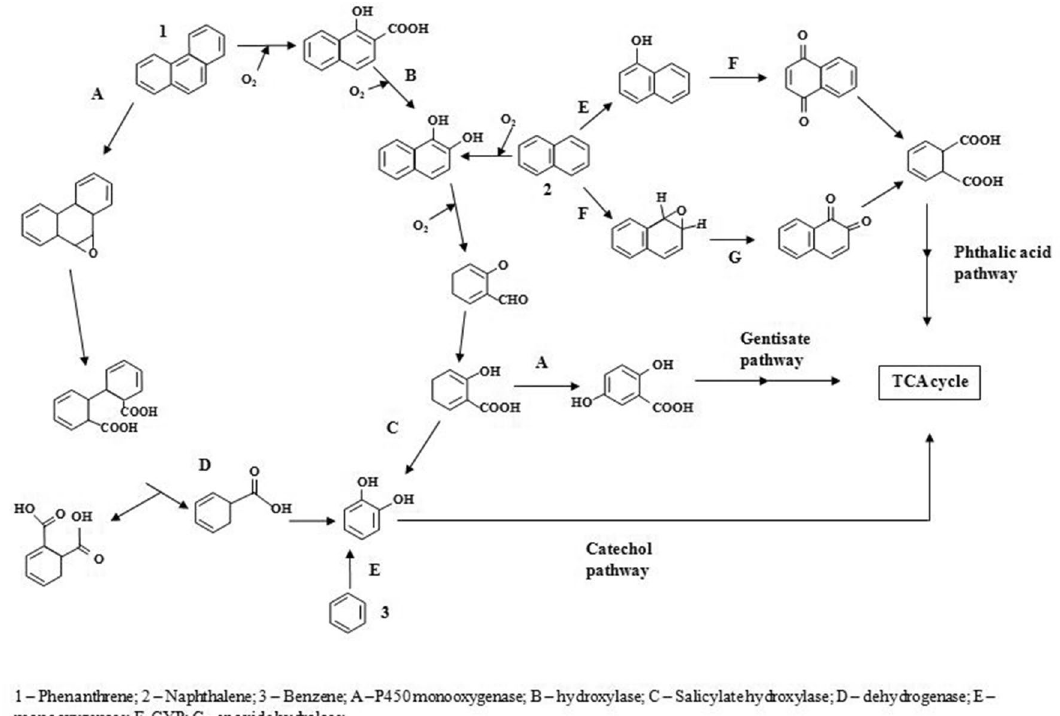
Figure 9. Proposed aerobic pathway involved during benzene, naphthalene and phenanthrene degradation in A. sydowii